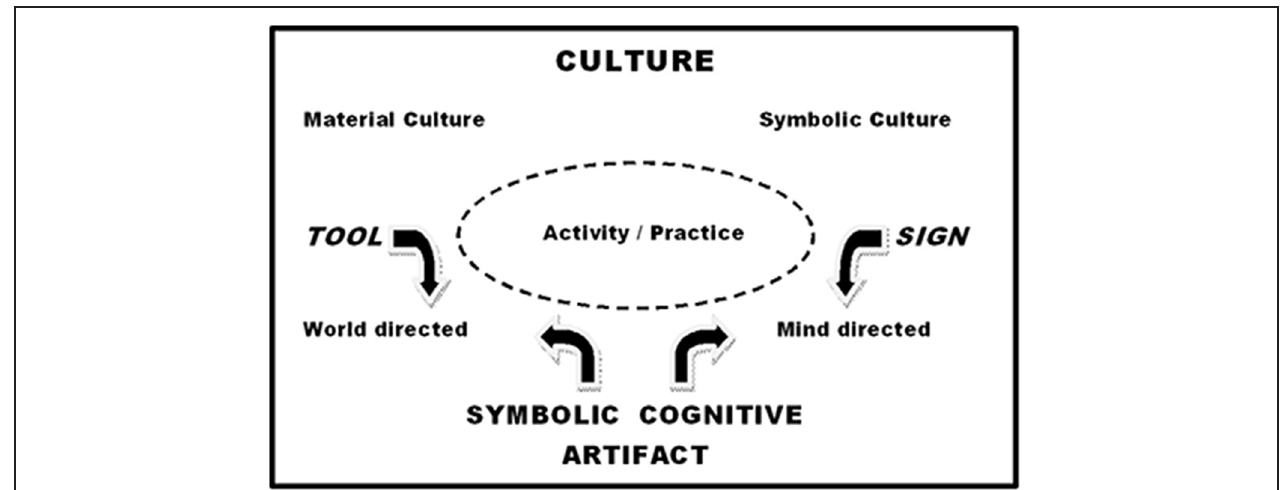
FIGURE 1 | The bi-directionality of mediated action employing symbolic cognitive artifacts. Figure © Chris Sinha.